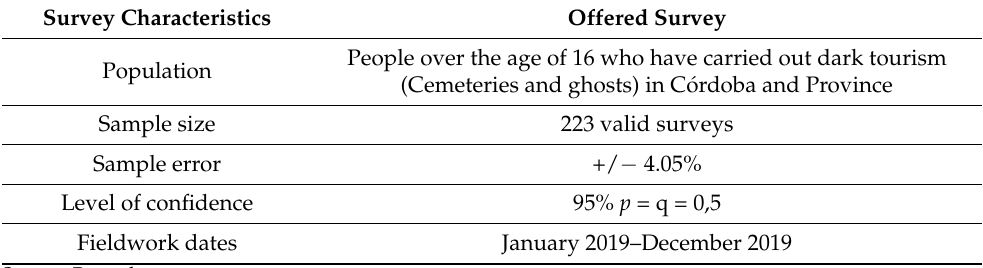
Table 1. Datasheet of the